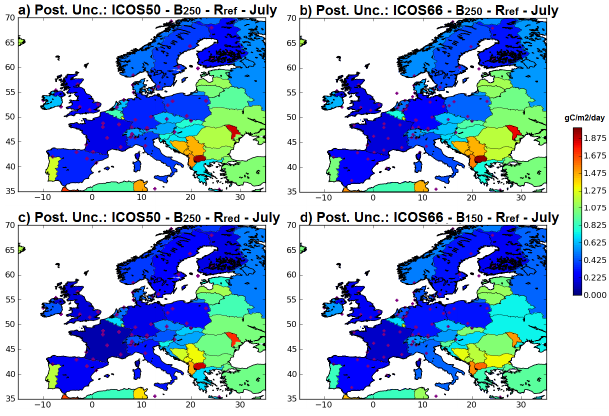
Figure A2. Standard deviations (gCm − 2 day − 1 ) of the poste- rior uncertainties at country scale for July when using ICOS50 (a, c) and ICOS66 (b, d) , the reference inversion configura- tion (a, b) , using B 150 instead of B 250 (d) and R red instead of R ref (c) . Red/blue colors indicate relatively high/low uncertainties (with min = 0gCm − 2 day − 1 and max = 1.975gCm − 2 day − 1 in the color scale).